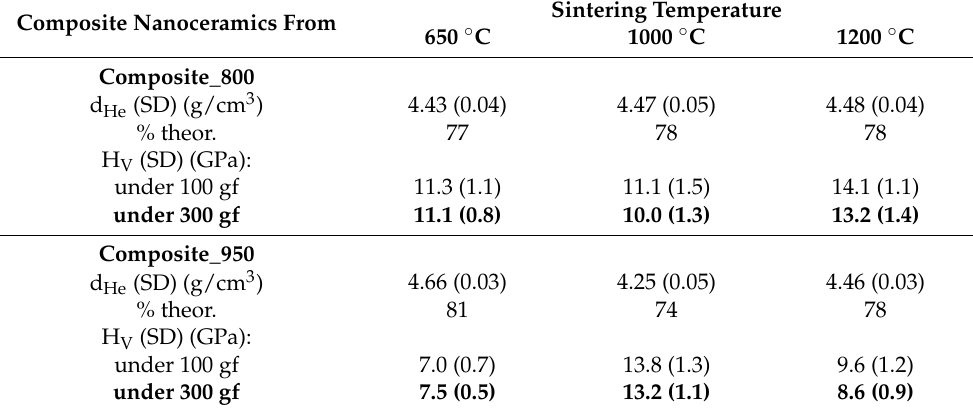
Table 3. Vicker’s hardness H v (100 and 300 g force loads) and helium density d He data for composite nitride nanoceramics in the system GaN–TiN. Percentages shown in helium density data were calculated with respect to the theoretical density of 5.73 g/cm 3 for composite h-GaN:c-TiN = 1:1 (molar basis). Note that relevant cases of individual GaN and TiN nanoceramics are included in [31] and [32],